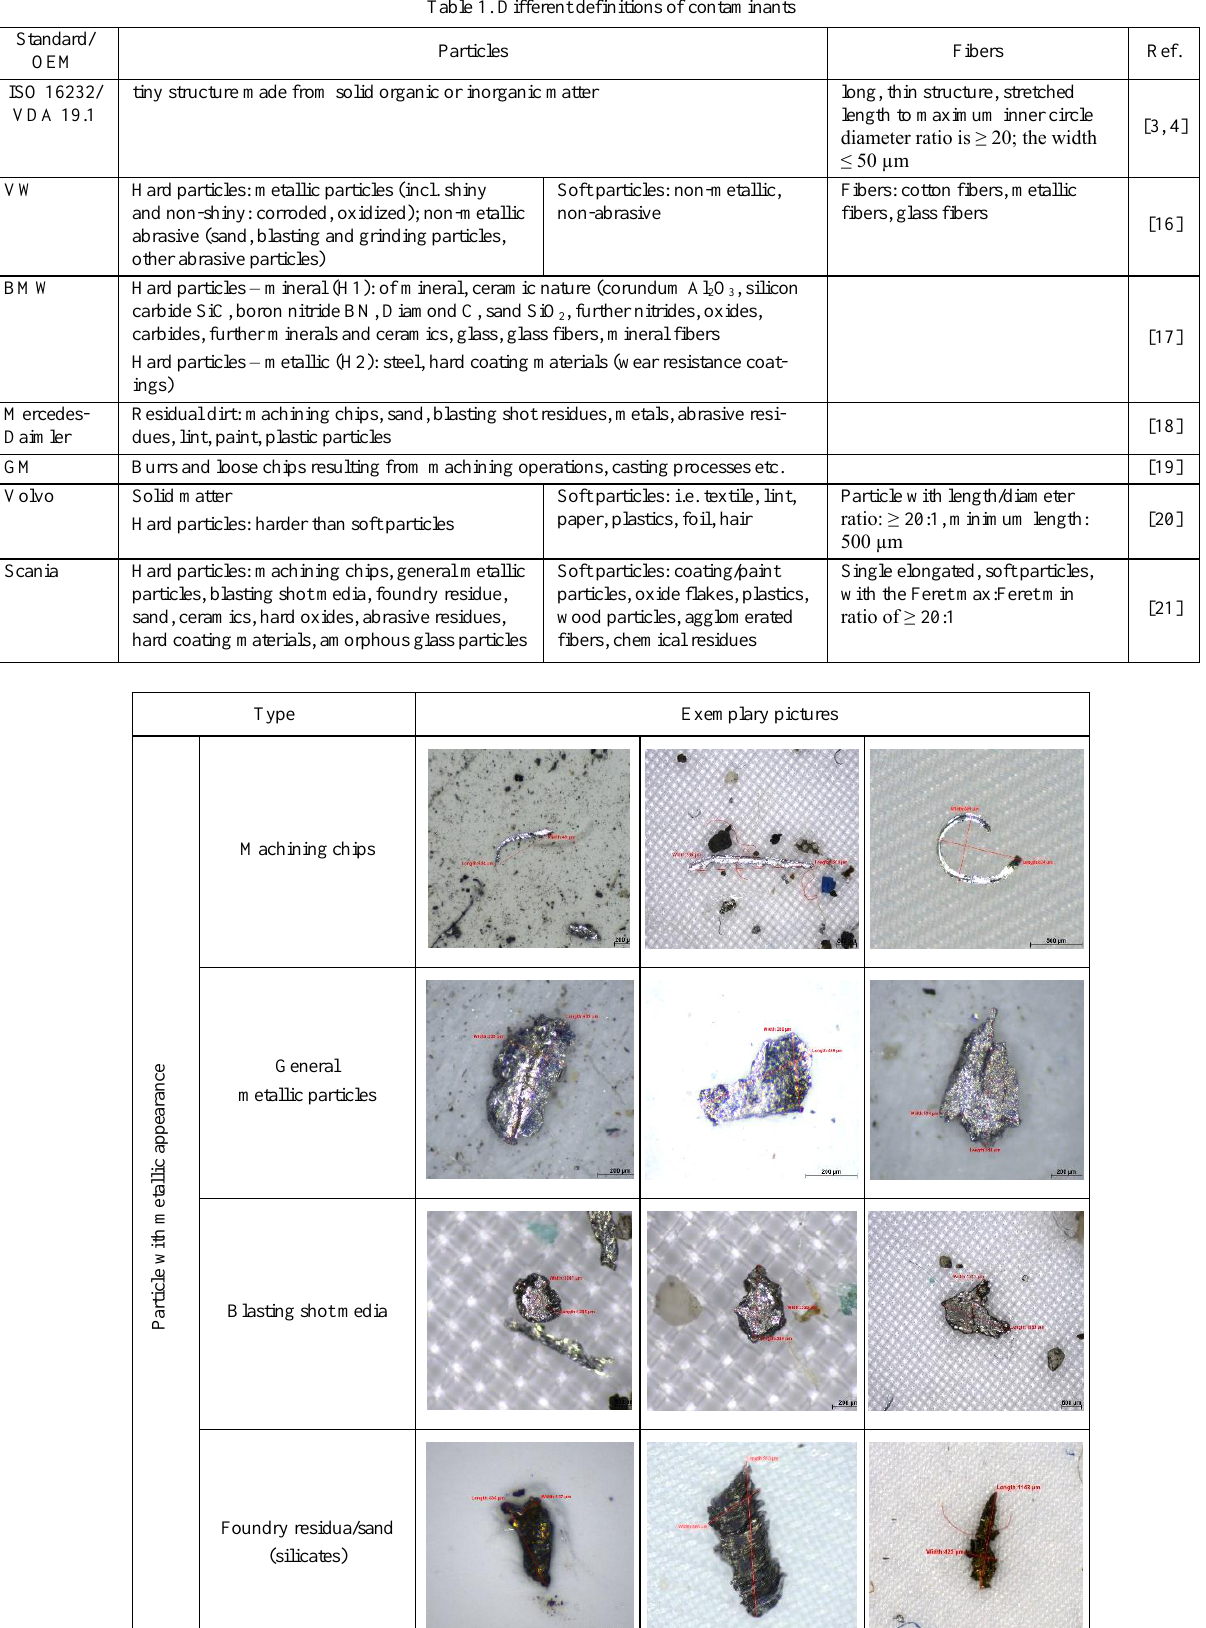
Table 1. Different definitions of contaminants